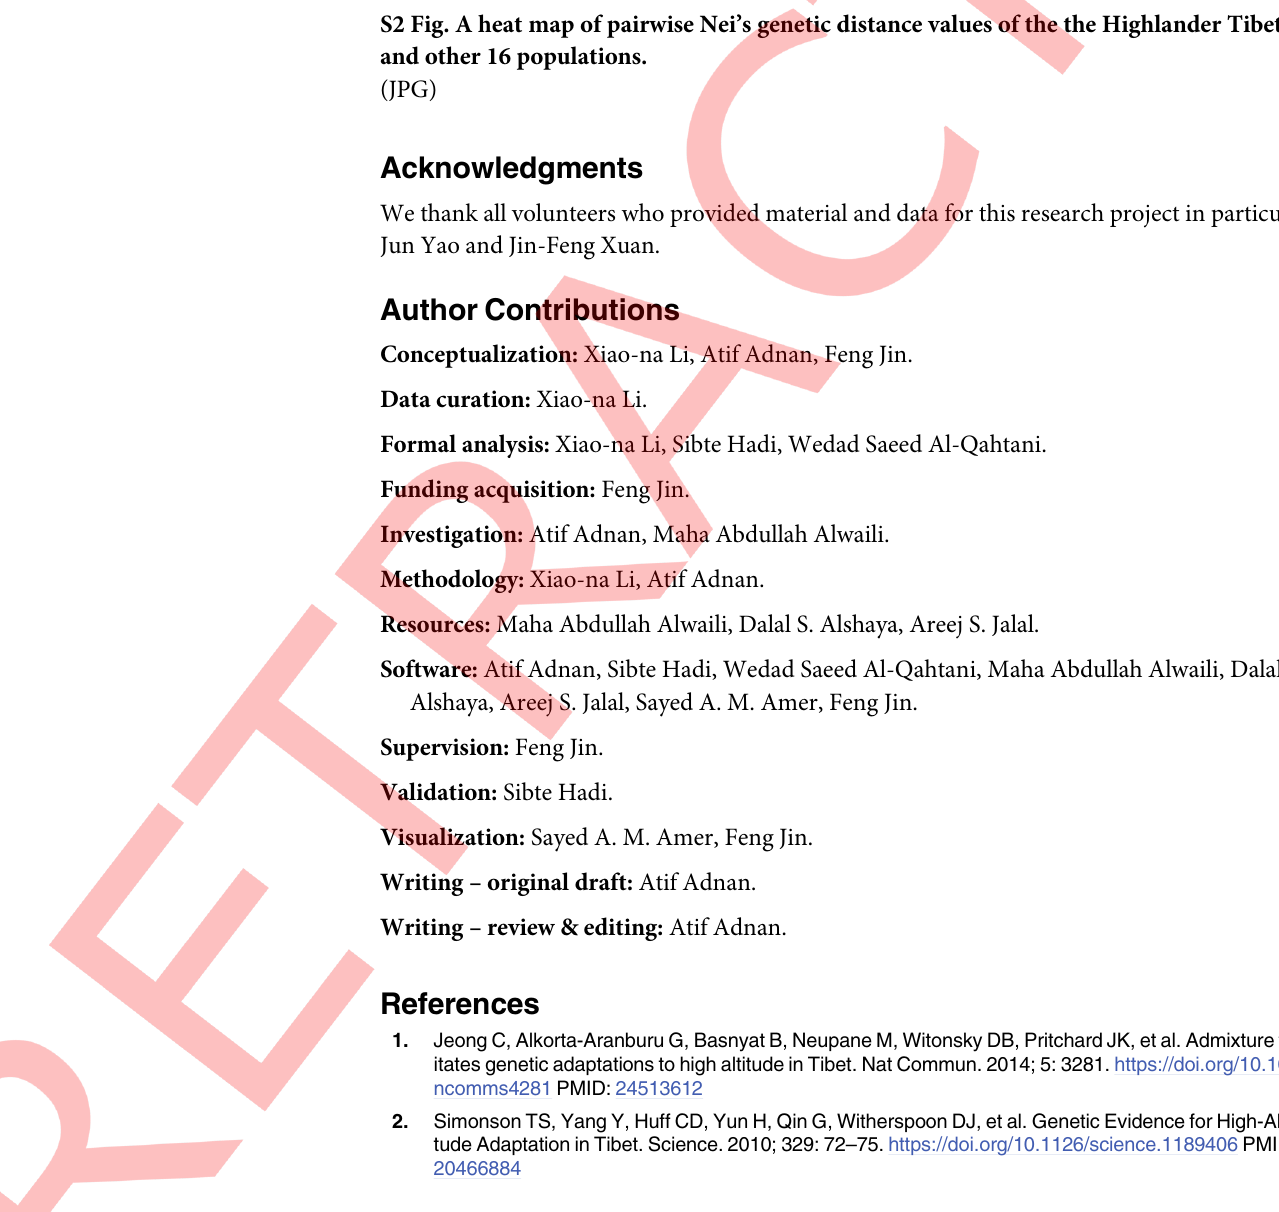
S5 Table. Pairwise Fst genetic distances between Highlander Tibets and 10 other reference populations. S6 Table. Nei’s genetic distance between the Highlander Tibetans and and sixteen previ- ously published populations based on twelve overlapping X-STR loci. (XLSX) S1 Fig. A heat map of pairwise Fst genetic distance values of the the Highlander Tibetan and other 10 populations. (JPG) S2 Fig. A heat map of pairwise Nei’s genetic distance values of the the Highlander Tibetan and other 16 populations.